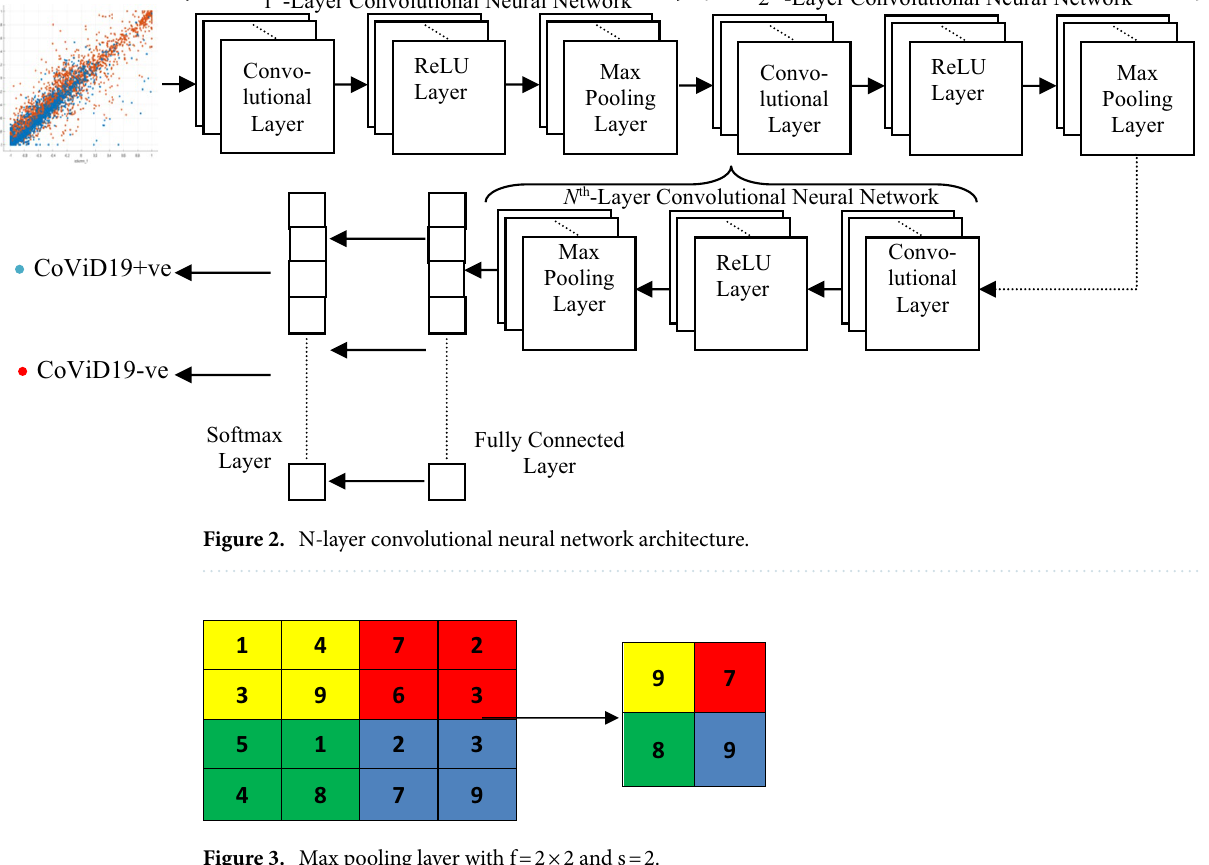
Figure 3. Max pooling layer with f = 2 × 2 and s =